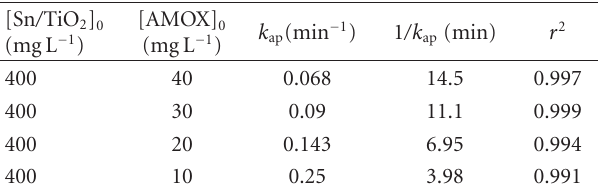
Table 4: Pseudo-first-order kinetic rate constants in photocatalytic experiments with di ff erent initial concentration of